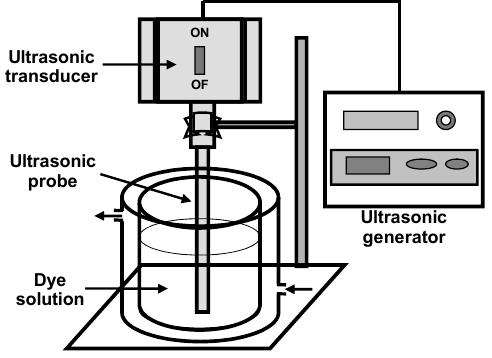
Figure 2. Schematic representation of the ultrasonic experimental setup. Samples were periodically taken from the reactor and the AB83 concentration was determined by UV/V spectrophotometry, at 448 nm, using an Agilent UV 8453 spectropho- tometer (Agilent Technologies, Madrid, Spain). The concentration of AB83 in an unknown sample was determined from the calibration curve (concentration range: 5–100 mg/L; R 2 = 0.9996). The results obtained showed a maximum deviation of